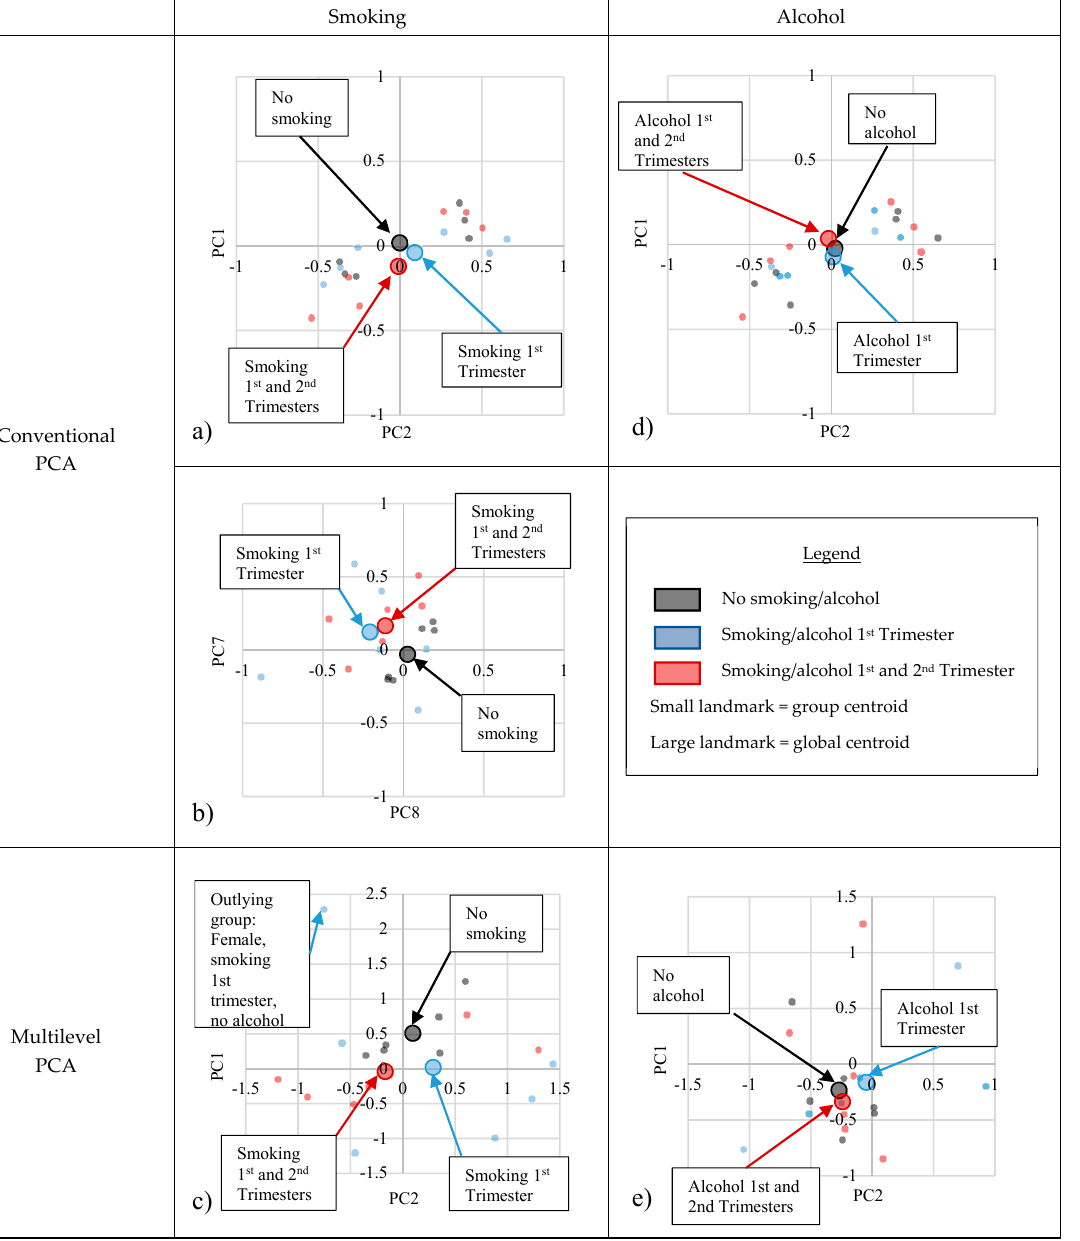
Figure 4. Scatter plots of the standardised component scores at PC1 and PC2 for conventional PCA ( a,b,d ) and mPCA ( c,e ). No obvious pattern in the separation of the group means is evident in conventional PCA PC1/2 ( a ). There is a suggestion of a pattern in conventional PCA PC7/8 ( b ) and mPCA smoking level PC2 ( c ). Subjects whose mothers did not smoke during pregnancy are possibly separated from those whose mothers smoked during the 1st trimester or both the 1st and 2nd trimesters. There is no obvious pattern in the separation of the group means with alcohol consumption during pregnancy ( d,e ). Scatter plots for conventional PCA PC3–10 are available as supplementary material.